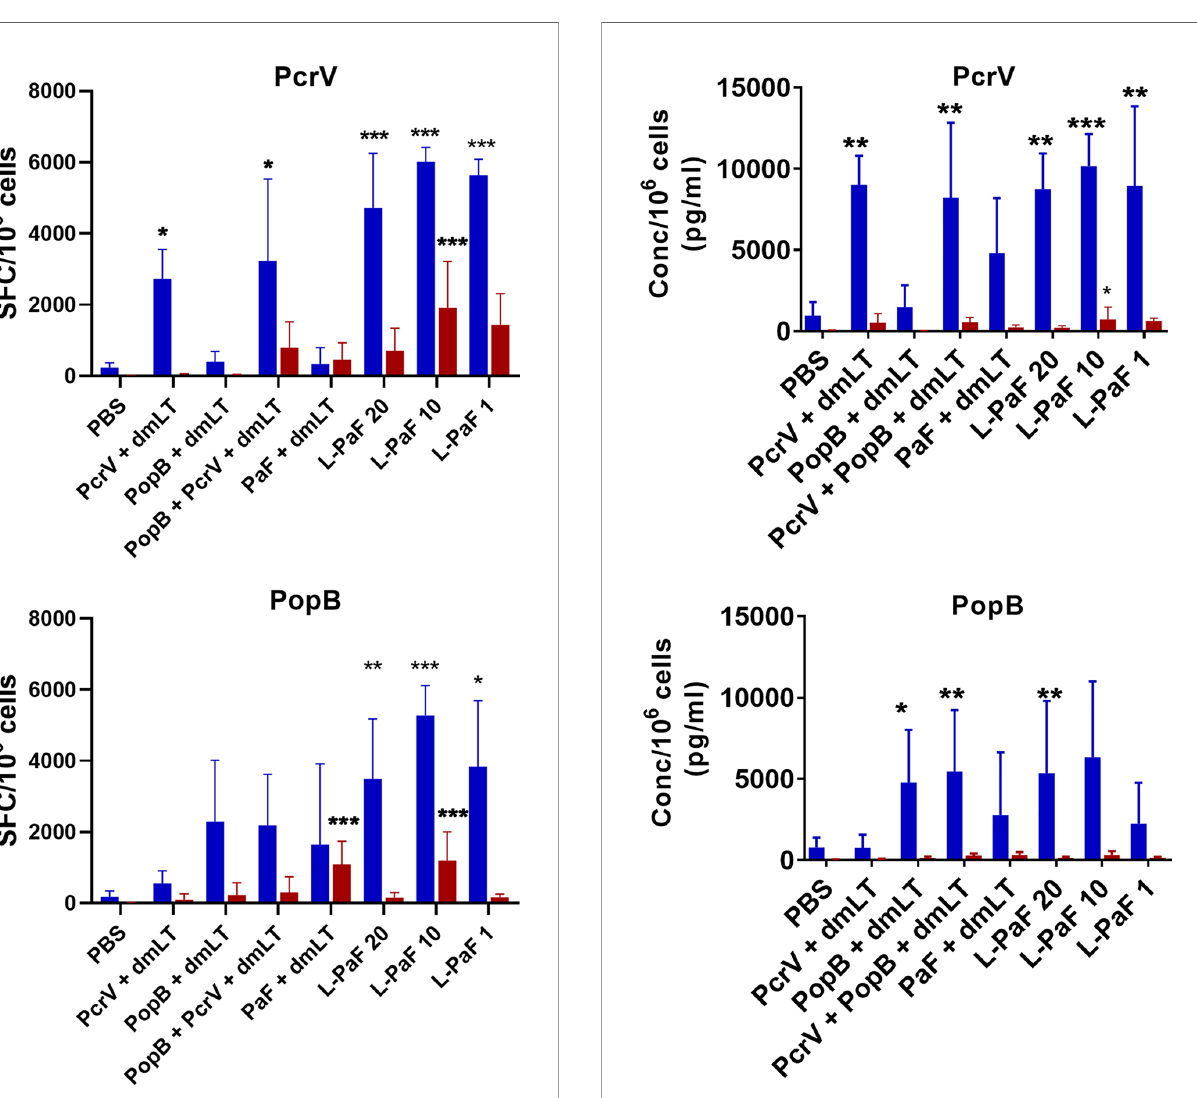
FIGURE 5 | Frequency of IL-17 and IFN- g secreting cells after antigen- speci fi c stimulation. The single lung cell suspensions from Figure 4 were used to assess antigen speci fi c IL-17 and IFN- g secreting cells. Cells were incubated with 10 µg PcrV (top) or PopB (bottom). IL-17 (blue bars) and IFN- g (red bars) secreting cells were enumerated by ELISpot and are presented here as spot forming cells/10 6 cells. The data are plotted as means ± SD for individual mice in each group. Signi fi cance was calculated by comparing groups that were unvaccinated (PBS) and mice vaccinated with antigens using two-way ANOVA. *p < 0.05; **p < 0.01; ***p < 0.001.